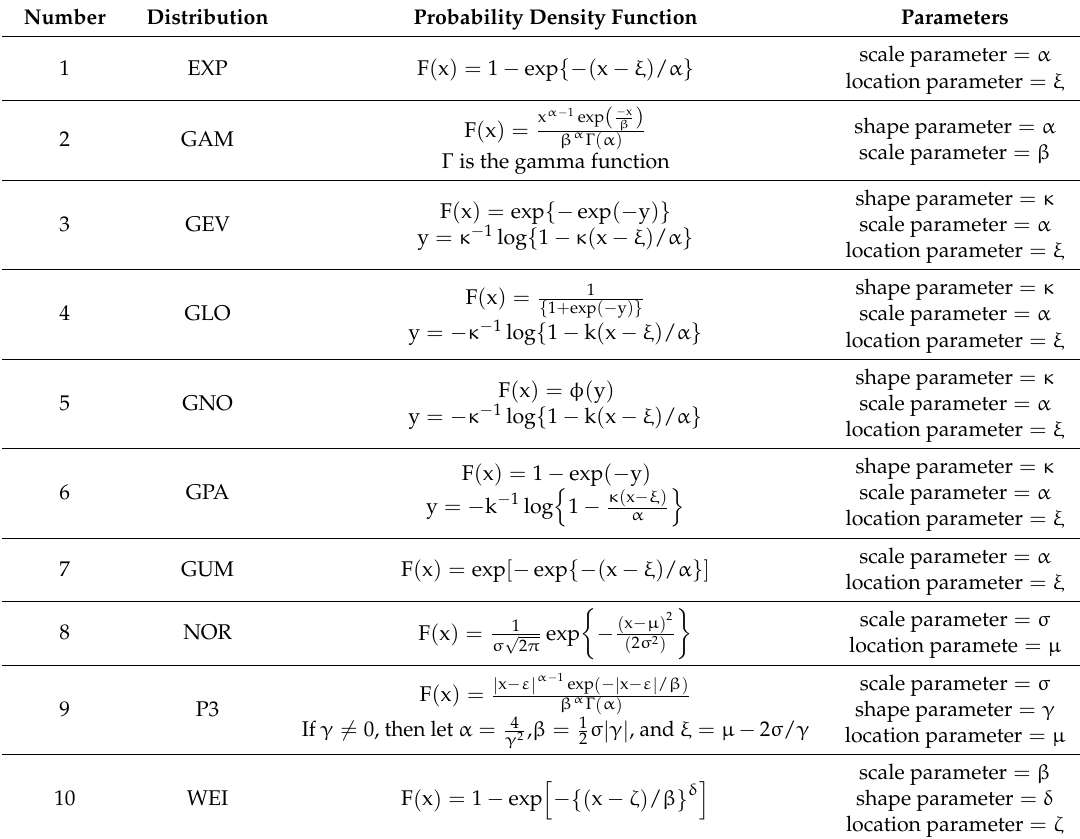
Table 2. The parameters and probability density functions (PDFs) of contending